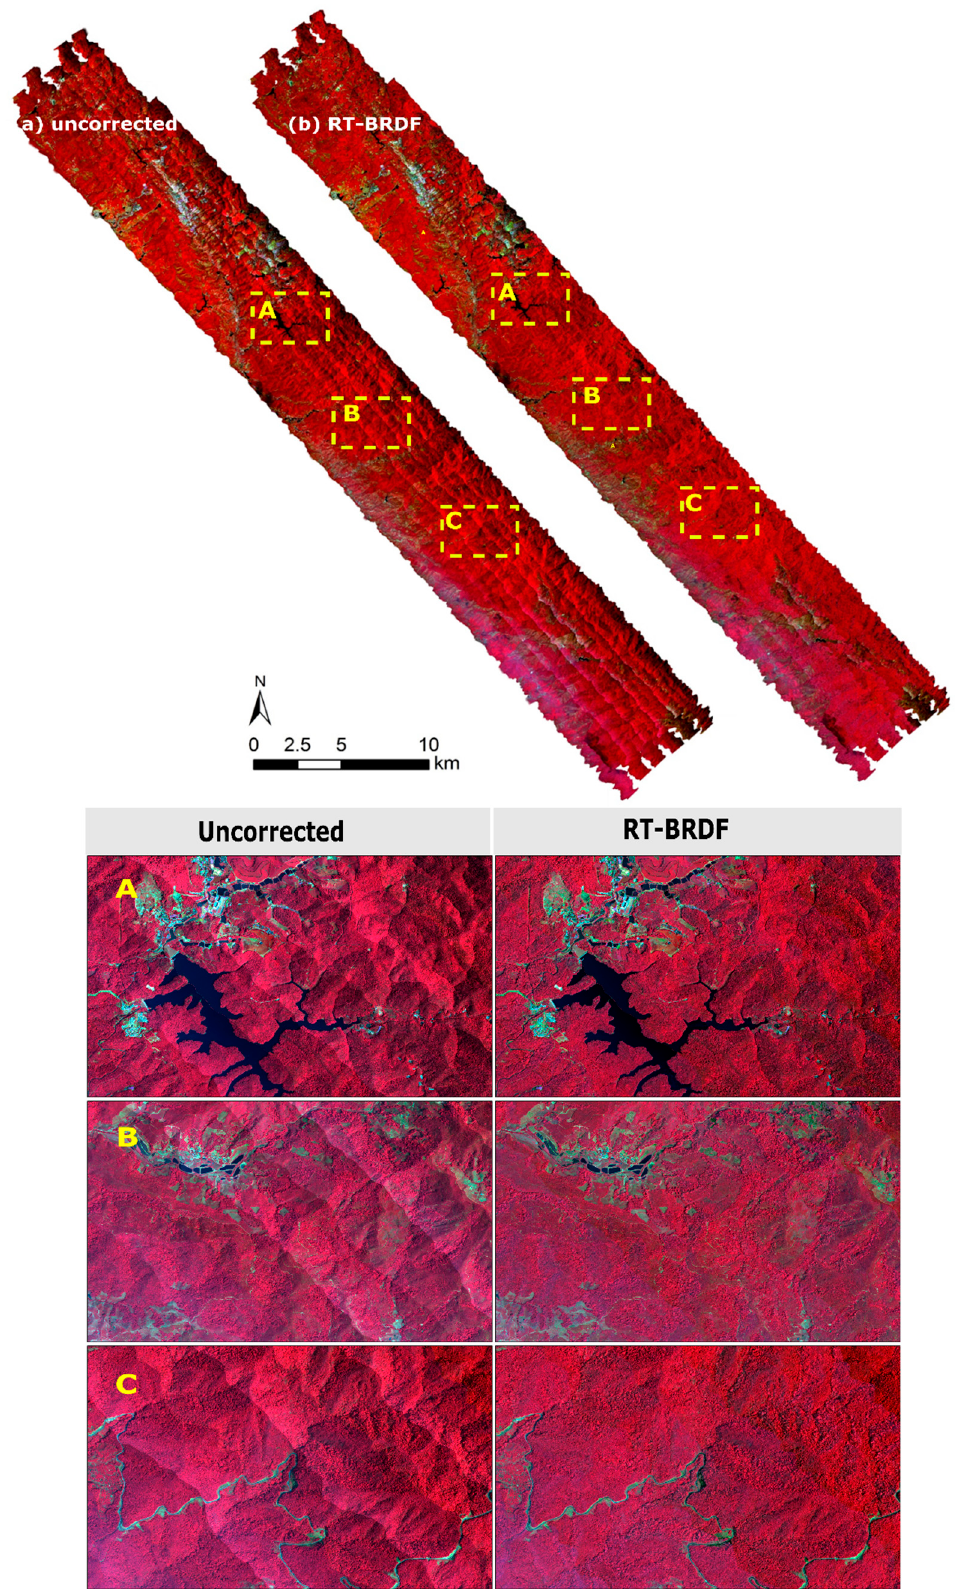
Figure 15. The comparison of uncorrected and RT-BRDF corrected hyperspectral images of the 04 / 04 / 2014 flight mission displayed as false-color composites. ( a ) Uncorrected hyperspectral image; ( b ) post-RT-BRDF corrected hyperspectral image. The uncorrected and post-RT-BRDF corrected close-in images are shown for three selected sites (sites A, B, and C).